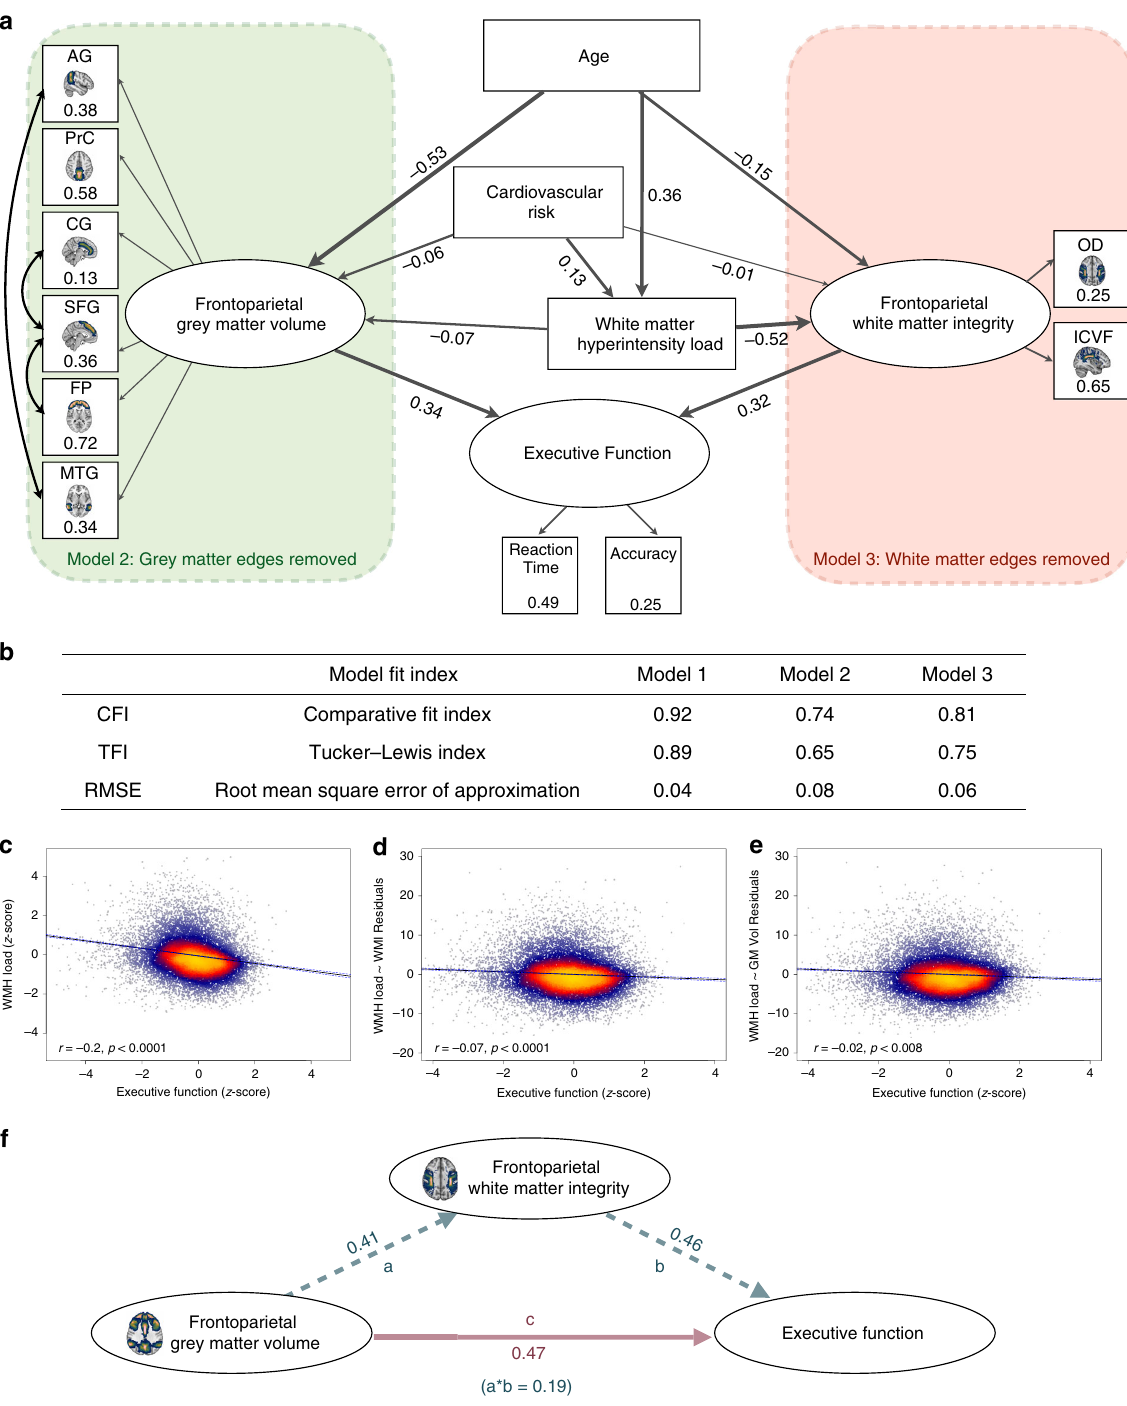
Fig. 3 Structural equation model, semi-partial correlation and mediation analysis. a Full structural model. All fi gures represent standardised beta coef fi cients. All paths signi fi cant to p < 0.001 except the path between cerebrovascular risk and frontoparietal white matter integrity. Black arrows represent covariances. Green box: indicates the frontoparietal grey matter edges that have been fi xed to zero in Model 2 red box: the frontoparietal white matter integrity edges that have been fi xed to zero in Model 3. b Model fi t indices comparing nested models (green and red boxes). Semi-partial correlation plots showing relationship between c WMH load ( z -score) and executive function ( z -score) Pearson ’ s r = − 0.20, p < 0.001; d controlling for white matter integrity Pearson ’ s r = − 0.07, p < 0.001 and e controlling for grey matter volume Pearson ’ s r = − 0.02, p < 0.008. f Mediation analysis. Values are standardised beta estimates. Path a: relationship between frontoparietal white matter integrity and frontoparietal grey matter volume. Path b: relationship between executive function and frontoparietal white matter. Path c: direct relationship between frontoparietal grey matter volume and executive function. Figures in brackets show beta estimates for the indirect path in which the relationship between frontoparietal grey matter volume and executive function is mediated by frontoparietal white matter integrity. AG angular gyrus; PrC precuneus; CG cingulate gyrus; SFG superior frontal gyrus; FP frontal pole; MTG middle temporal gyrus; OD orientation dispersion; ICVF intracellular volume fraction; WMH white matter hyperintensity; GM Vol grey matter volume; WMI white matter